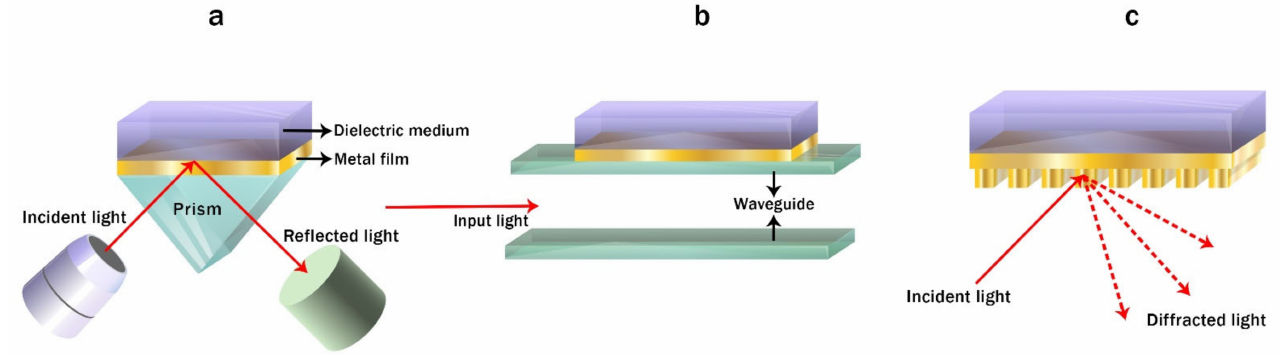
Figure 8. The excitation of surface plasmon resonance by different light coupling methods for SPR biosensing, including ( a ) by Kretschmann configuration, ( b ) by the optical wave-guide coupling, and ( c ) by grating